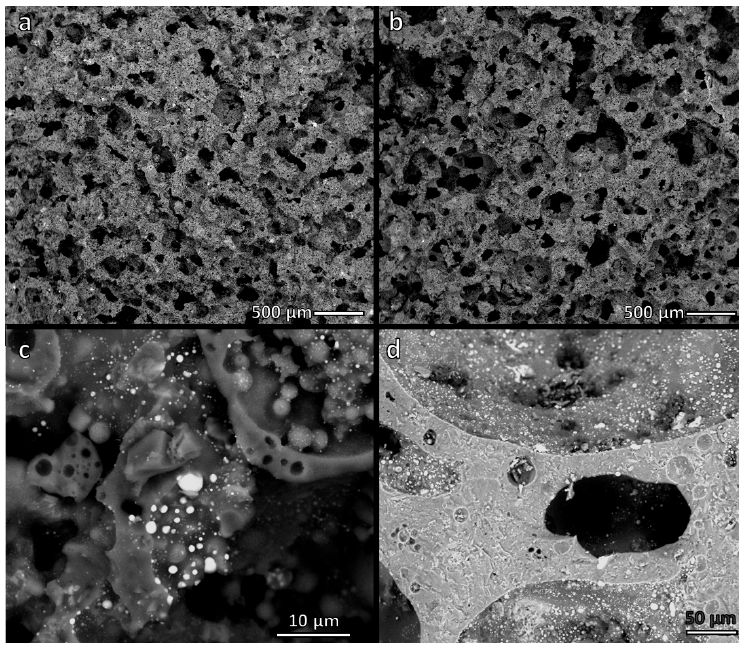
Figure 7. Scanning electron microscopy analysis of samples fired at 1000 °C: ( a , c ) 5S; ( b , d ) 7S.